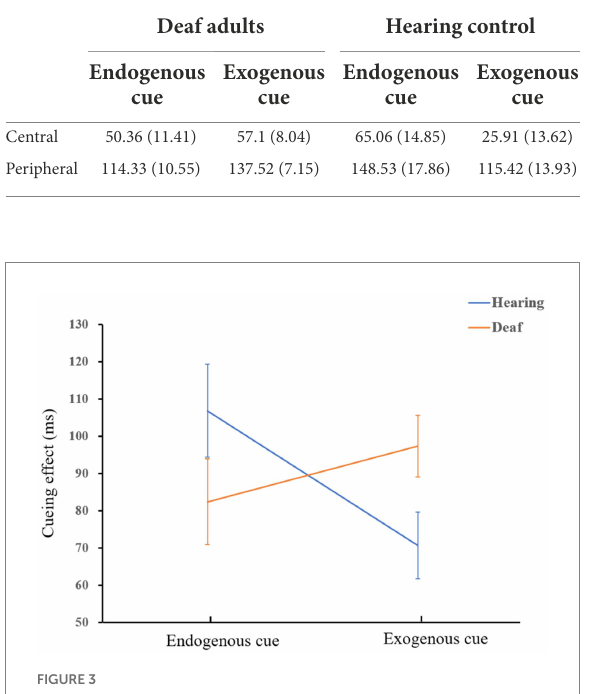
TABLE 2 Mean cueing effect (ms) and standard error of deaf and hearing groups on stimuli from different cue types and locations when there is a long ISI.